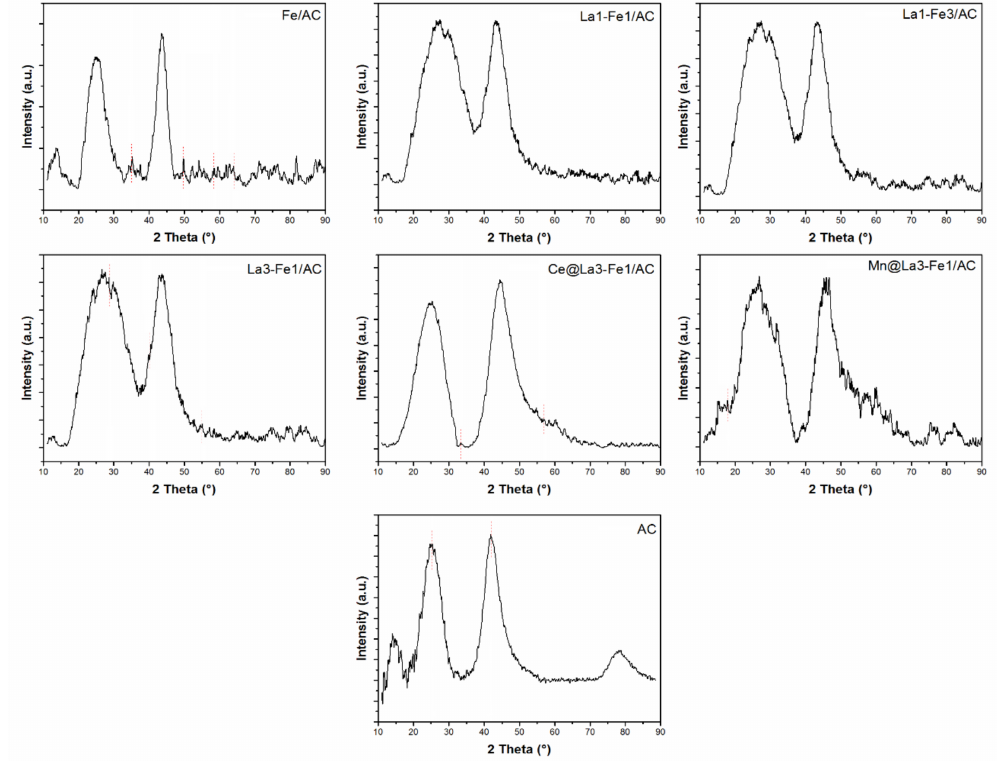
Figure 2. XRD profiles of the synthesized catalysts: Fe / AC, La1-Fe1 / AC, La1-Fe3 / AC, La3-Fe1 /